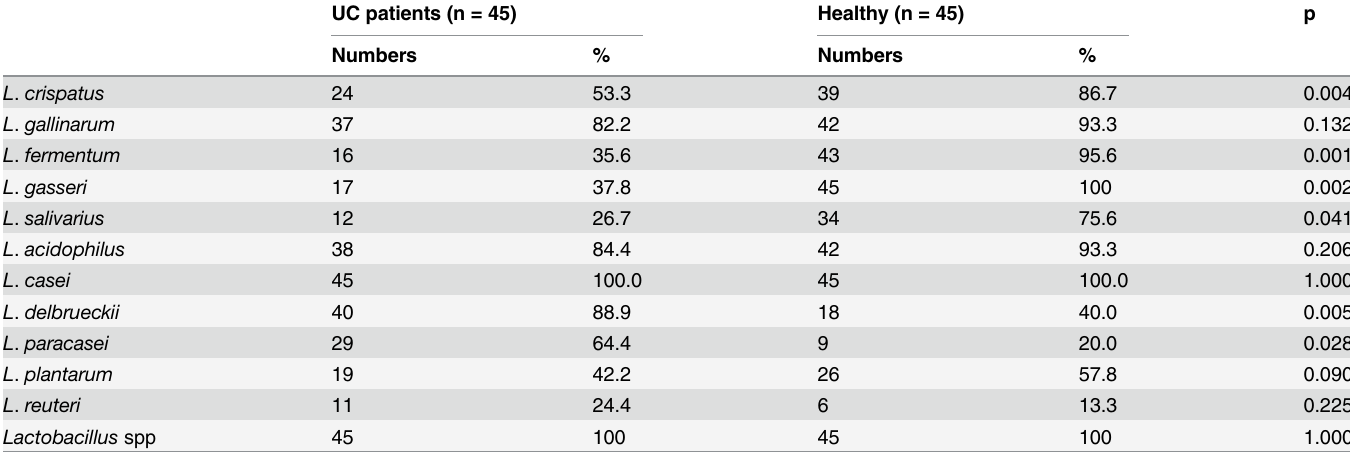
Table 3. The detection rate of 11 Lactobacillus species in UC patients and healthy